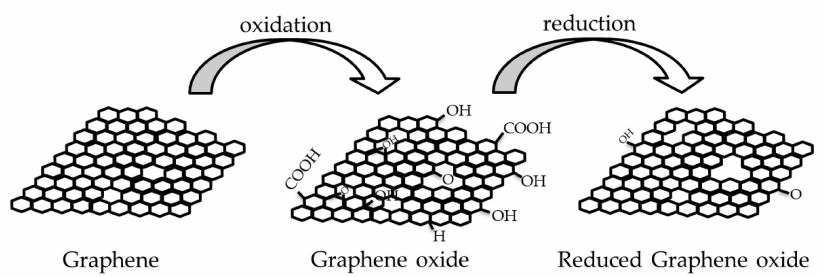
Figure 1. Forms of graphene, graphene oxide and reduced graphene